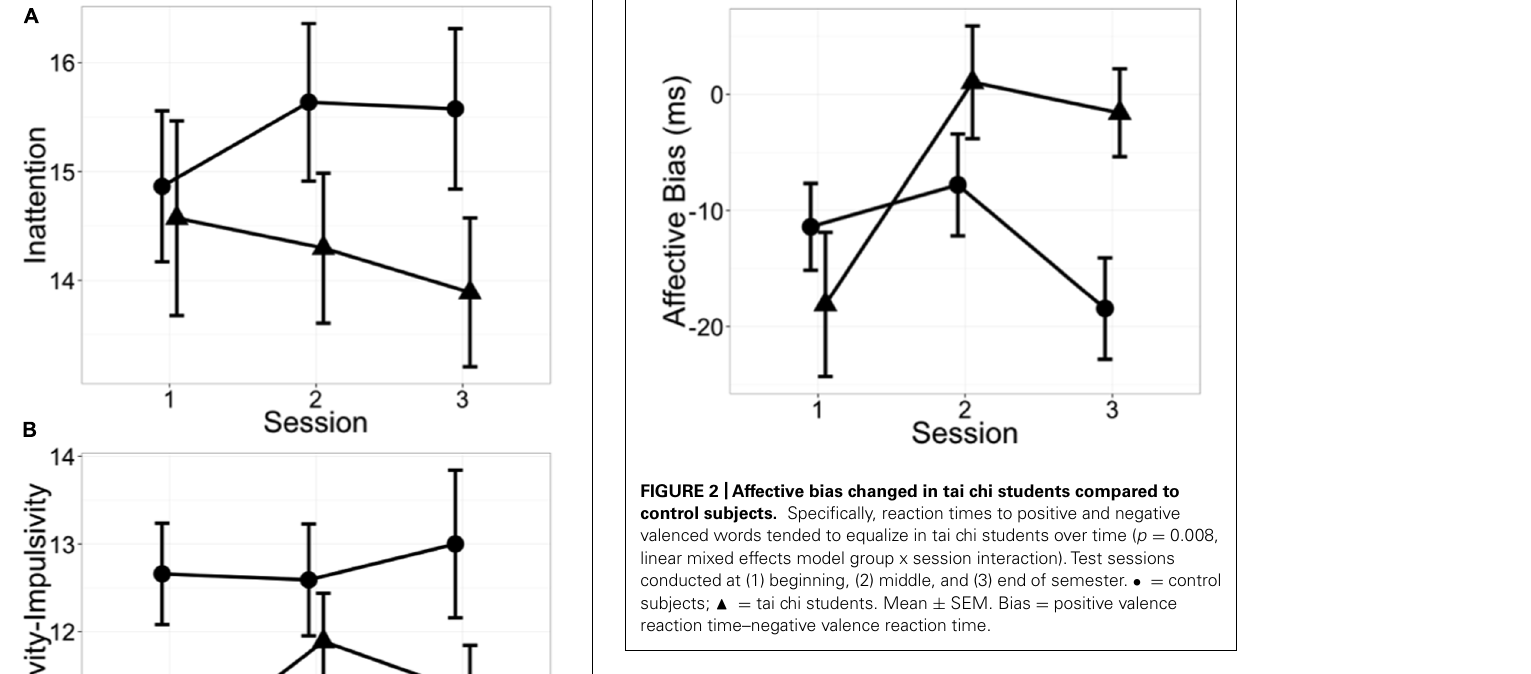
Table 5 | Correlations betweenADHD subscores and reaction time variability: at baseline and change over time. Pearson